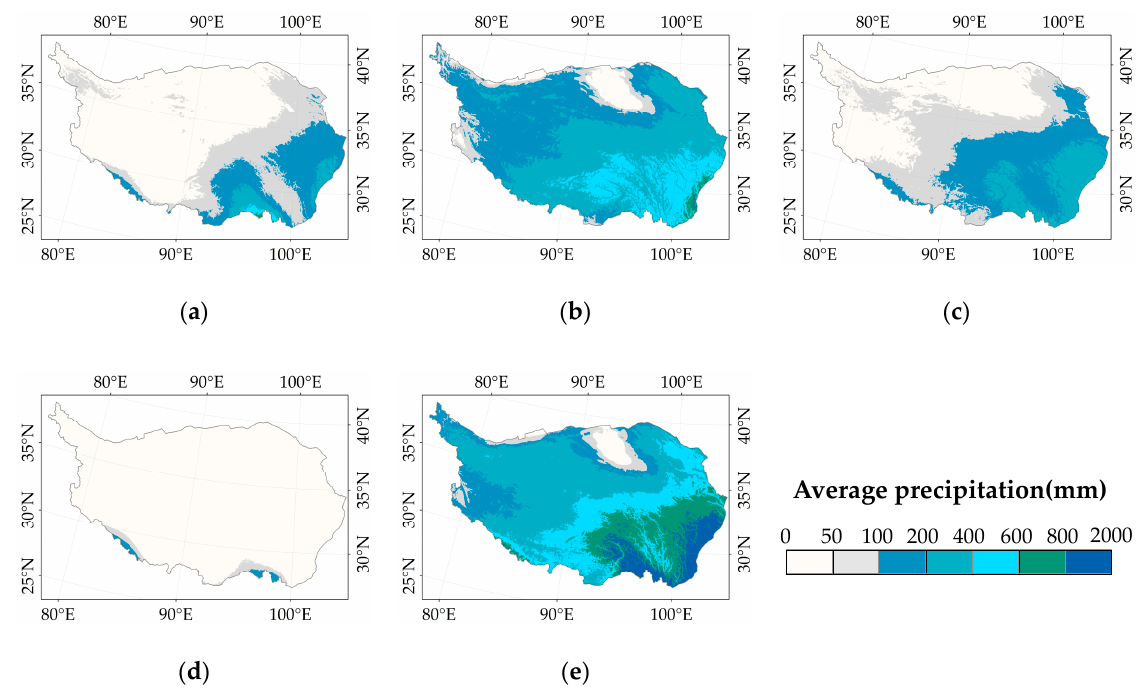
Figure 4. Spatial distribution of average precipitation from 1967 to 2016: ( a ) spring; ( b ) summer; ( c ) autumn; ( d ) winter; ( e ) annual.